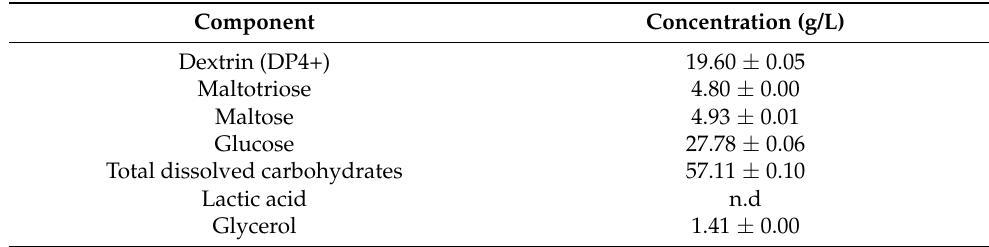
Table 3. Concentration of sugars and fermentation products in the stillage obtained after fermentation and distillation of bread hydrolysate.